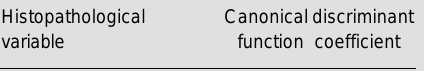
Table 1 - The most significant hepatic histopatho- logical variables for the distinction between IHC and EHC according to the discriminant function test in this study.